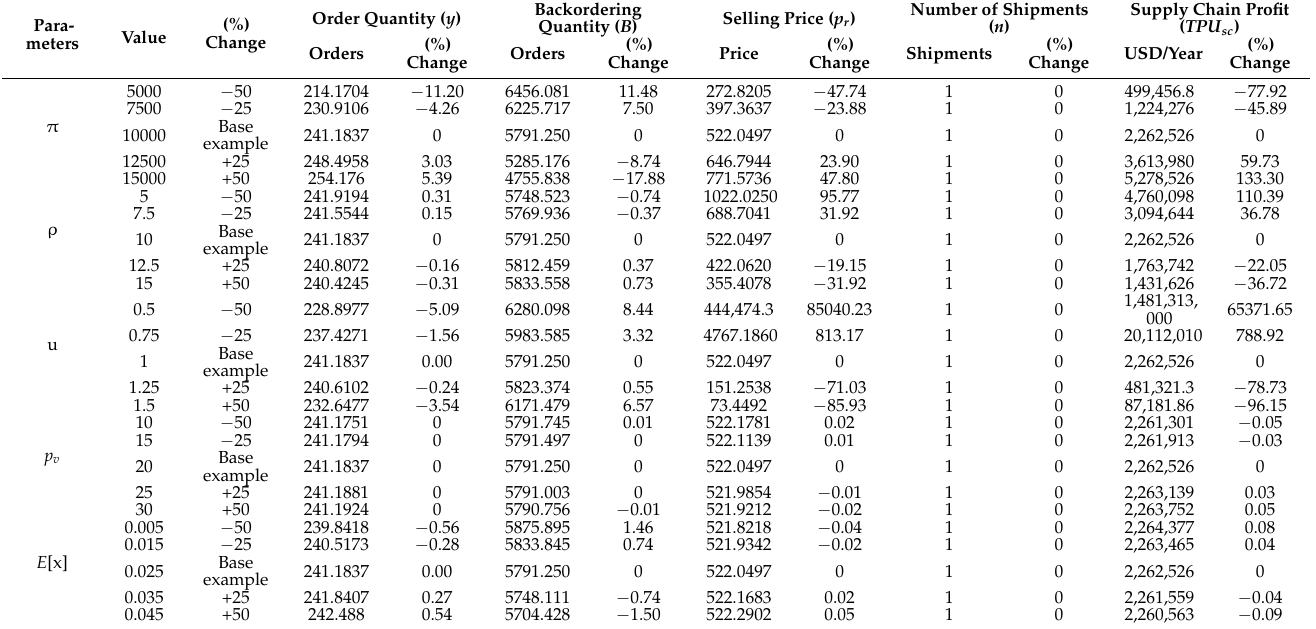
Table 2. Effects of the demand parameters ( π , ρ , u ) , the price of imperfect growing items ( p v ) and the percent of the imperfect growing items ( E [ x ]) on the optimal